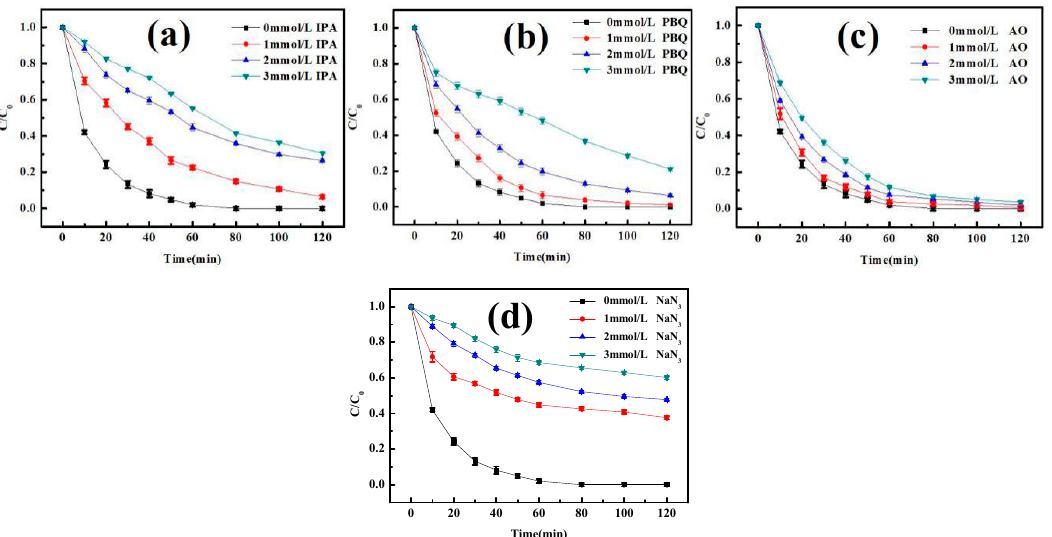
Figure 10. Effects of ( a ) isopropanol, ( b ) p-benzoquinone, ( c ) ammonium oxalate (AO), and ( d ) sodium azide (NaN 3 ) on the degradation of BPA in the heterogeneous photo-Fenton system with FePcS– PMA–LDH.